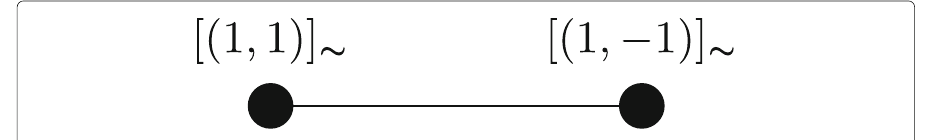
Fig. 2 Congruence dot product graph of R 2 × R